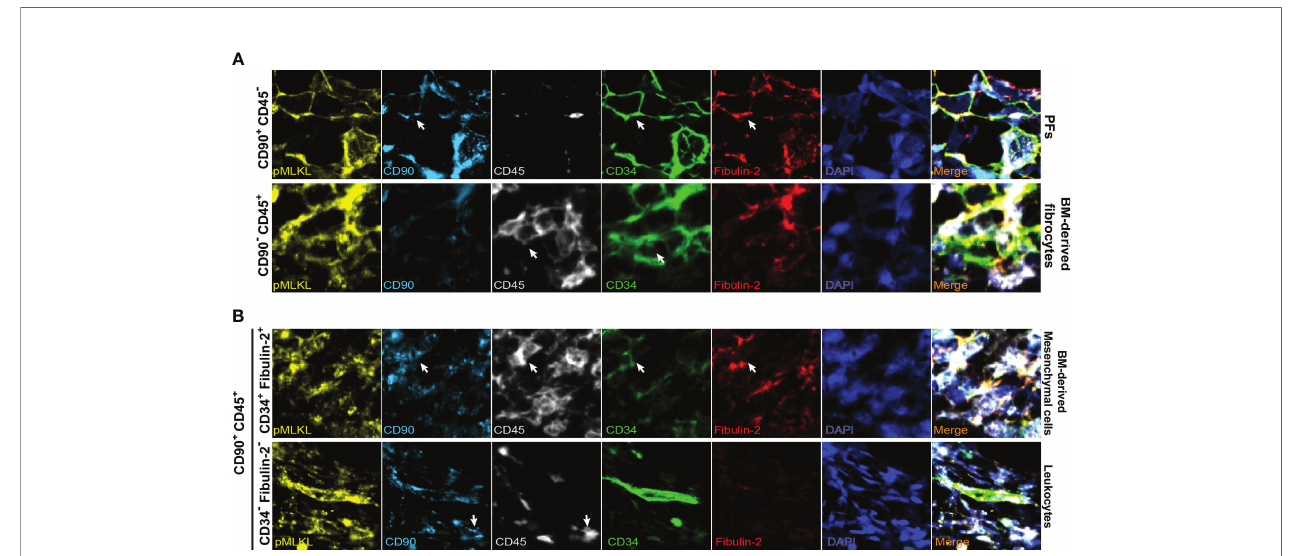
FIGURE 6 | Representative multiplex immuno fl uorescent images of distinct subpopulations of pMLKL expressed cells in portal triads (magni fi cation, 2000X). Arrows indicate the cells with positive staining. The pMLKL + cells featured by CD90 + CD45 - (PFs), CD90 - CD45 + (BM-derived fi brocytes) (A) , CD90 + CD45 + CD34 + fi bulin-2 + (BM-derived mesenchymal cells) and CD90 + CD45 + CD34 - fi bulin-2 - (leukocytes) (B) were